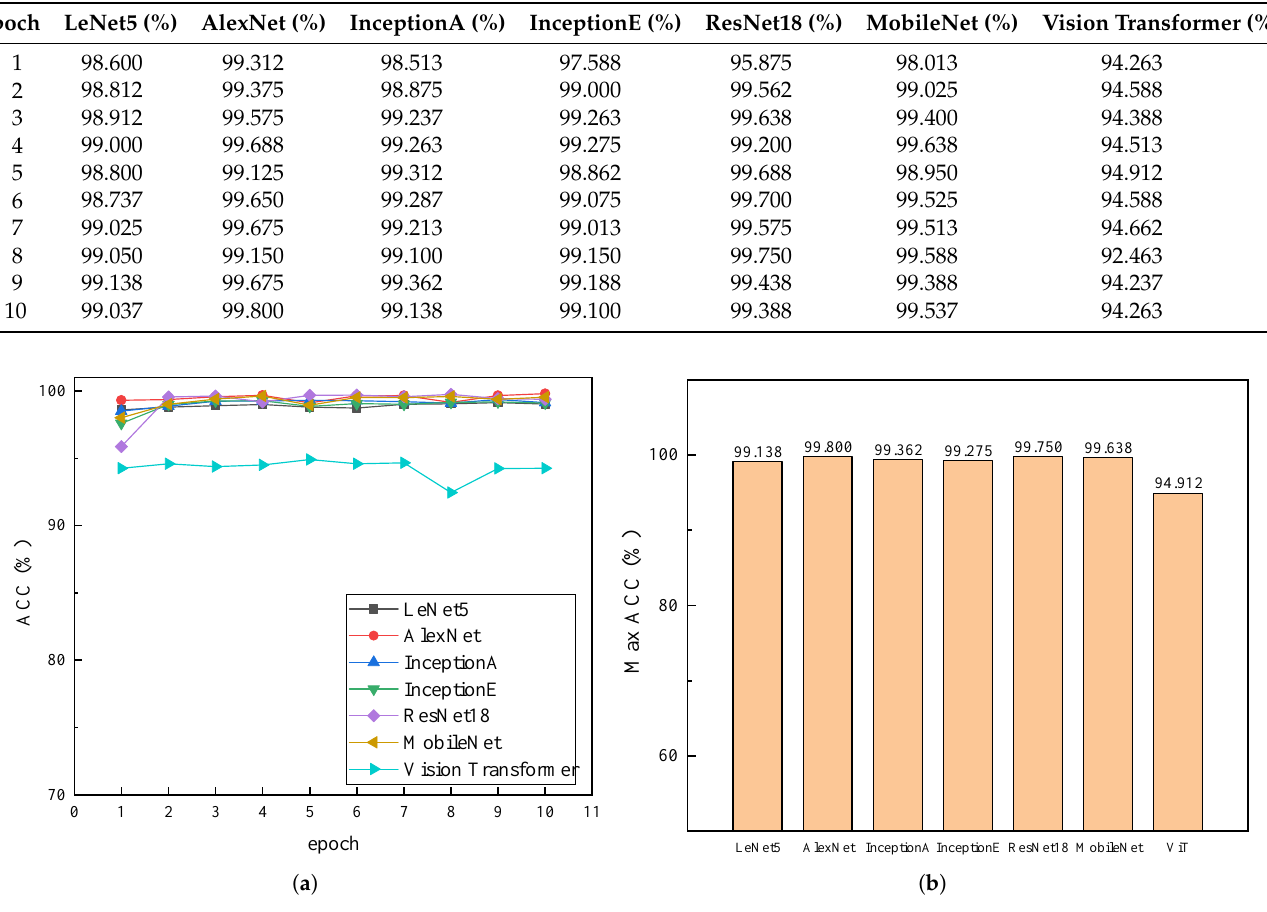
Figure 10. Comparison of accuracy before data augmentation. ( a ) Comparison of accuracy of each model before data augmentation. ( b ) Comparison of the highest accuracy of each model before data